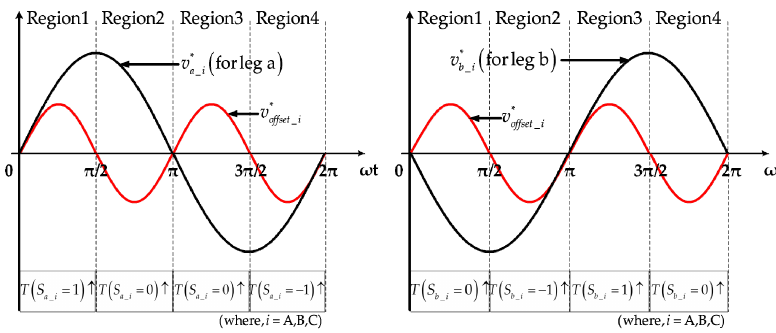
Figure 1. Waveforms pole voltage reference. Voltage, v g * ; offset voltage, v offset *.